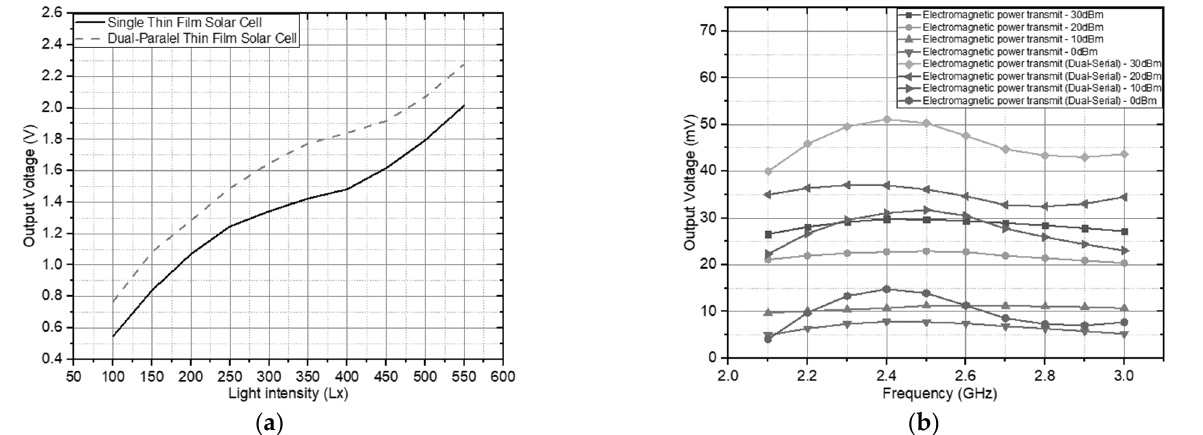
Figure 15. Rectenna output voltage from the source: ( a ). thin-film solar cells; ( b ). dual feed CP Antenna. After testing the solar cell, the RF circuit was then tested in transmitting RF energy.